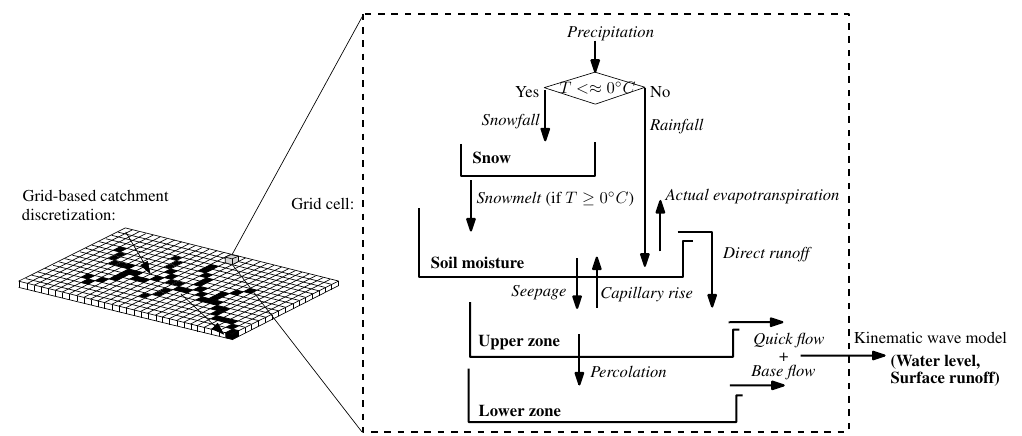
Figure 3. Left: catchment discretization using a grid-based approach including the channel delineation. Arrows indicate flow direction. Right: schematic structure of the HBV-96 model for each grid cell. Model states are in bold and model fluxes in italics (after Rakovec et al.,